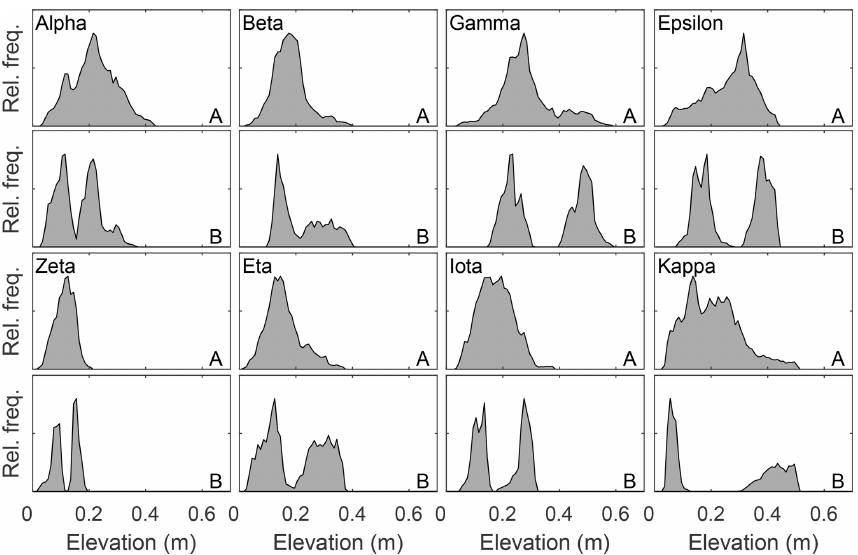
Figure 4. Plot-level relative frequency distribution of height in plots with randomly chosen locations within a site containing a perceived hummock and adjacent hollow (Table 1 – random plot locations). Relative height distributions are shown for all of panel (a) and for a hummock and hollow panel (b) , whose area corresponds to the size of a large flux measurement chamber. Elevations are referenced to the lowest point of the reconstructed surface and set to